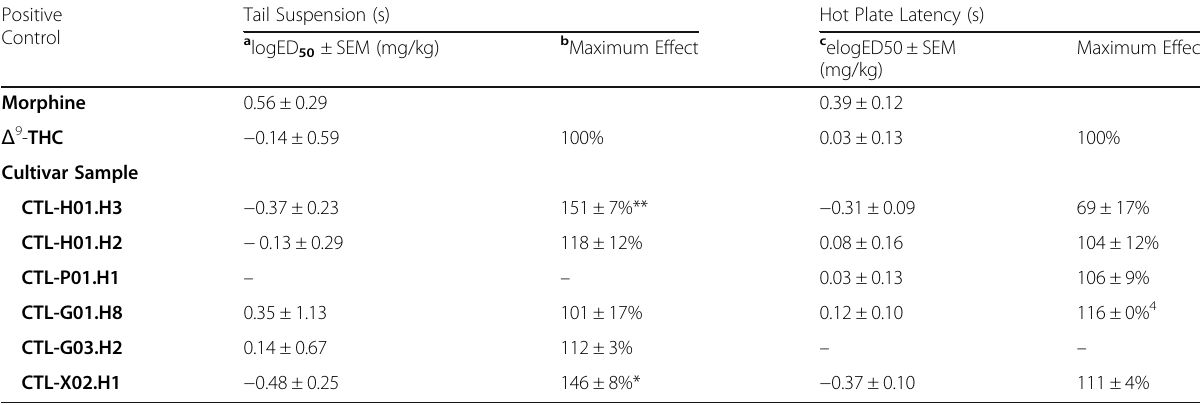
Table 3 The EC 50 values for each cultivar in each behavioral assay Positive